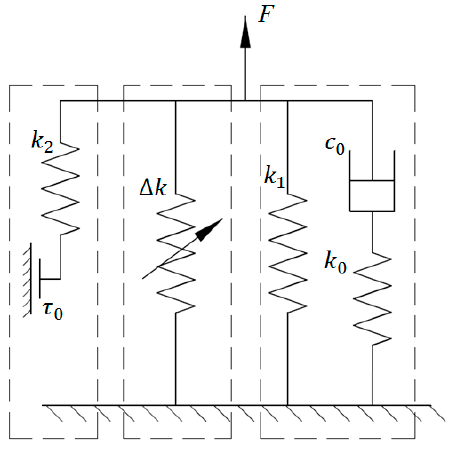
Figure 3. Rheological model.